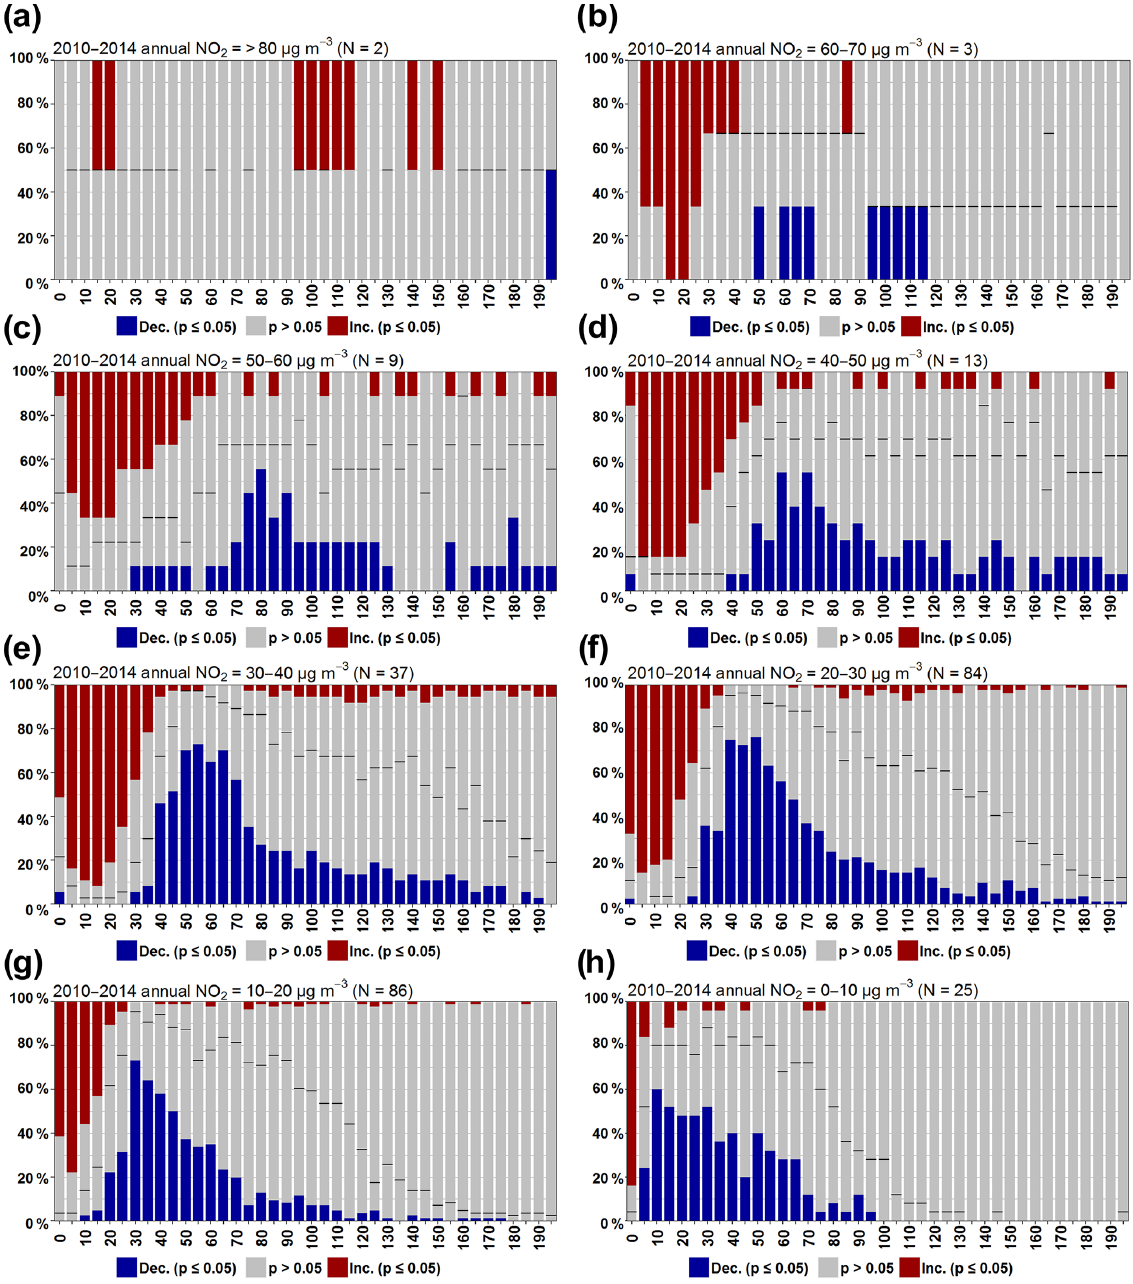
Figure 12. Proportion of sites with significant decreasing (blue), increasing (red) ( p <0.05), and non-significant (grey) trends in the percent- age contribution from hourly NO 2 concentrations in 5µgm − 3 bins to annual average NO 2 between 2000 and 2014, for sites with 2010–2014 average annual NO 2 concentrations (NO 2AA ) of (a) >80µgm − 3 , (b) 60–70µgm − 3 , (c) 50-60µgm − 3 , (d) 40–50µgm − 3 , (e) 30–40µgm − 3 , (f) 20–30µgm − 3 , (g) 10–20µgm − 3 , and (h) 0–10µgm − 3 . Trend estimates were calculated using a first-order autoregressive (AR(1)) model. The black line represents the division between decreasing and increasing trends within the non-significant